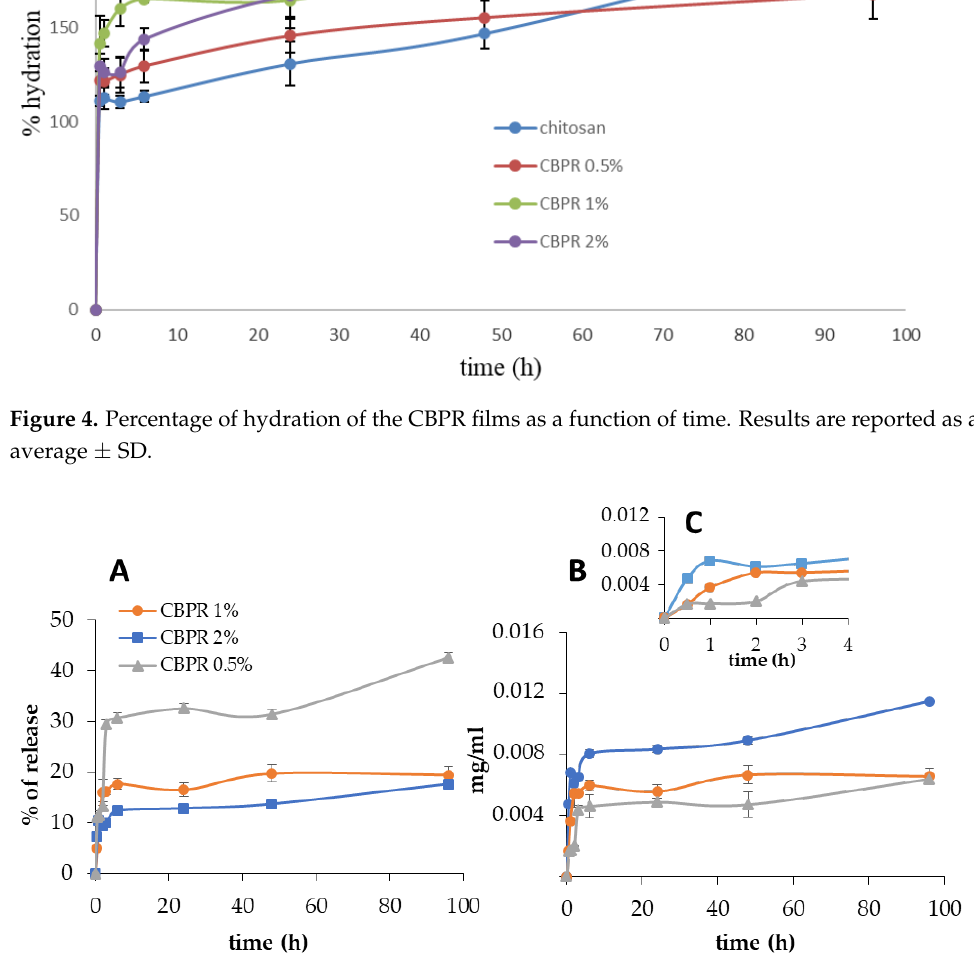
Figure 4. Percentage of hydration of the CBPR films as a function of time. Results are reported as an average ± SD.